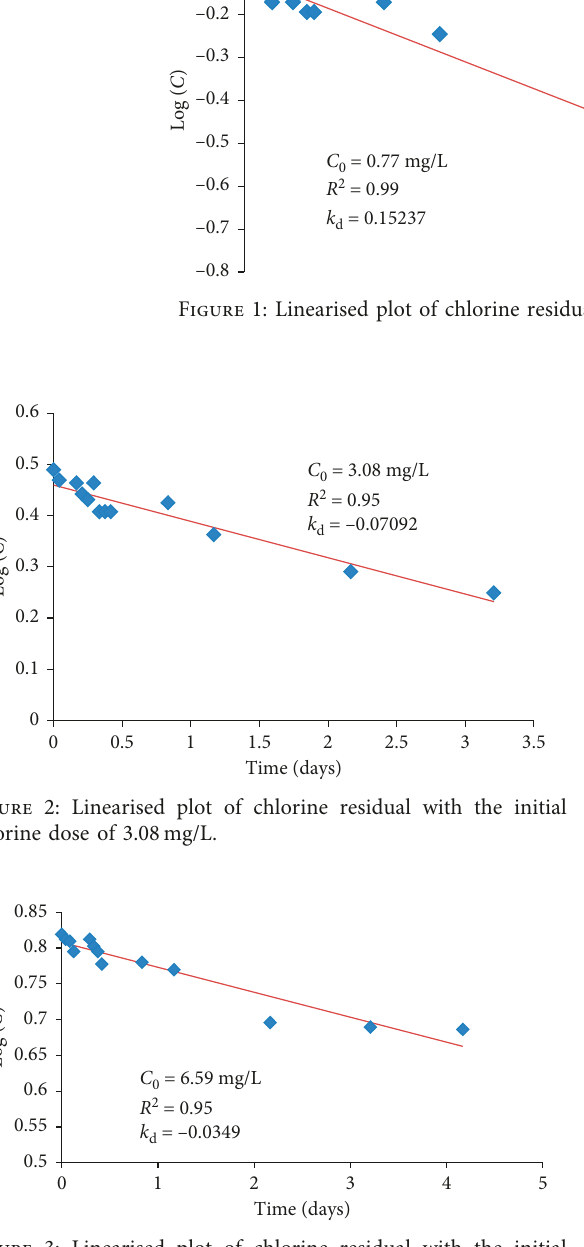
Figure 3: Linearised plot of chlorine residual with the initial chlorine dose of 6.59mg/L.